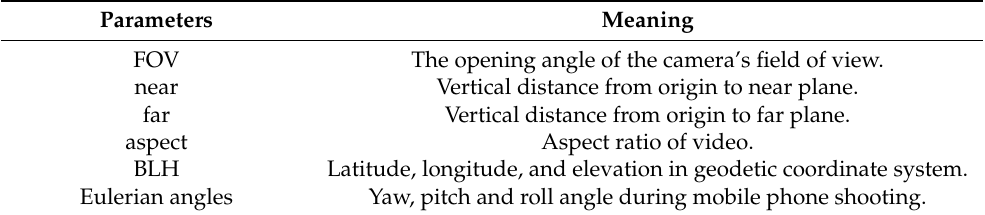
Table 1. The parameters of establishing the viewing frustum model coordinate system.